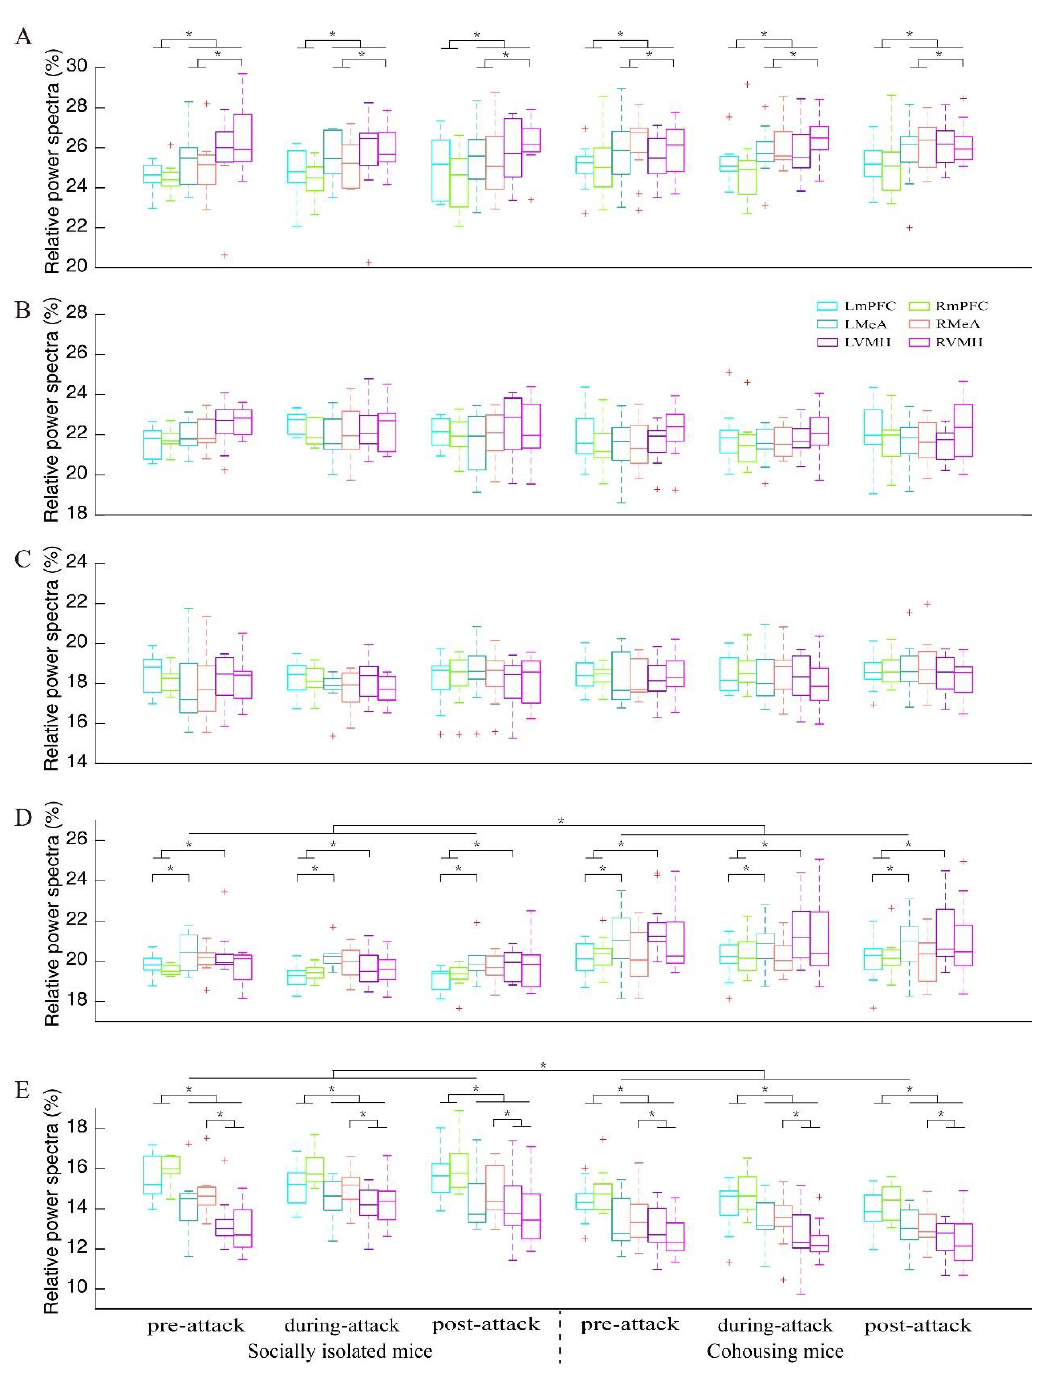
Figure 3. Relative power spectra for each brain area and each time condition for delta ( A ), theta ( B ), alpha ( C ), beta ( D ) and gamma ( E ) bands in the socially isolated mice and cohousing mice. Data points beyond the whiskers are displayed using red +. LmPFC and RmPFC, the left and right medial prefrontal cortex; LMeA and RMeA, the left and right medial amygdala; LVMH and RVMH, the left and right ventromedial hypothalamus. * p < 0.05.